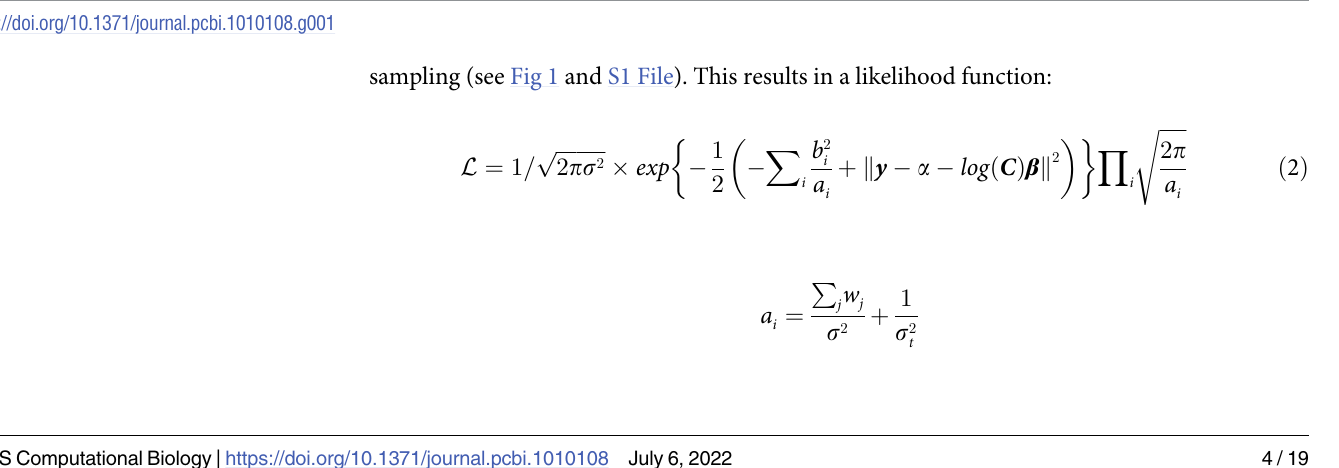
Fig 1. Outline of the BRACoD method to identify bacteria associated with a physiological outcome. Known data includes the relative abundances of bacterial groups at a defined level of classification ( c for microbiome sample i ) and sample-specific measurements of a physiological outcome ( x ). The model uses several unobserved i i variables to identify associations between the two sources of data. First, to correct for the compositional nature of the data, relative abundances are related to absolute abundances by an unknown per sample total abundance, which is modelled with a lognormal distribution with hyperparameters μ t and σ 2 t (although, in the final form of the likelihood equation, this variable was marginalized out; see Methods). To identify the associations, the physiological outcome is modelled as linearly related to the log absolute abundance of each of the bacterial species via unobserved regression coefficients which are inferred by the model. Contributing bacteria are selected using a stochastic search variable selection (SSVS) procedure where the Bernoulli variable p designates if a given bacteria is a contributor or a non-contributor. The Bernoulli variable controls whether or not the regression coefficient is included (non-zero) or excluded (forced to